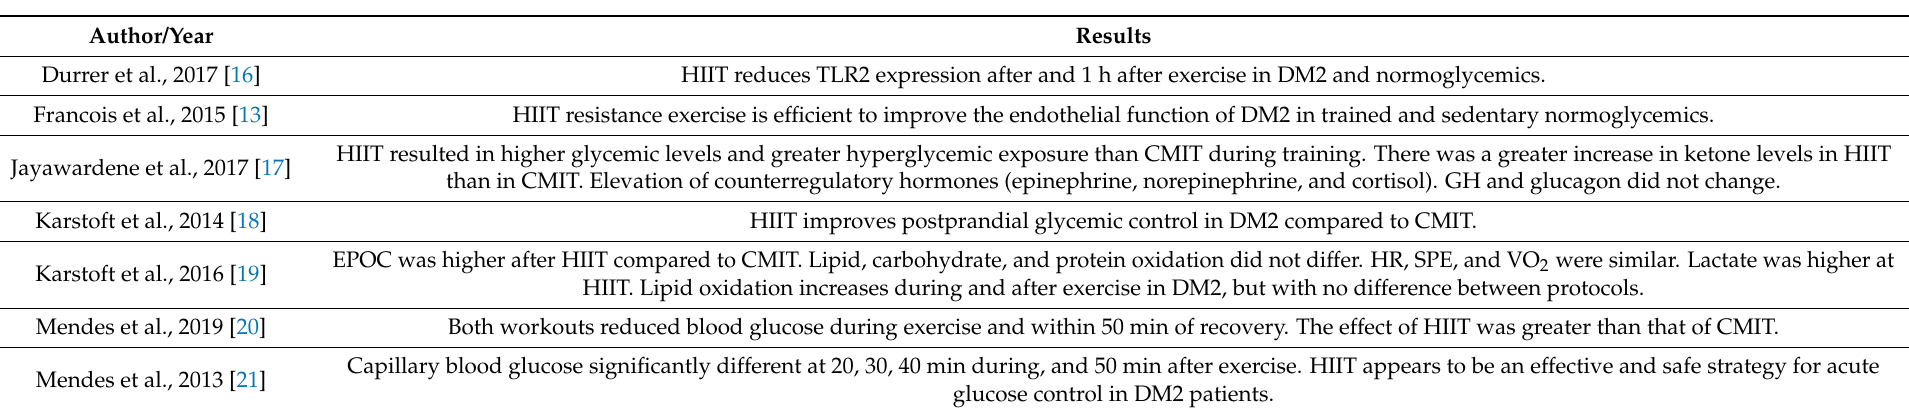
Table 4. Results of the